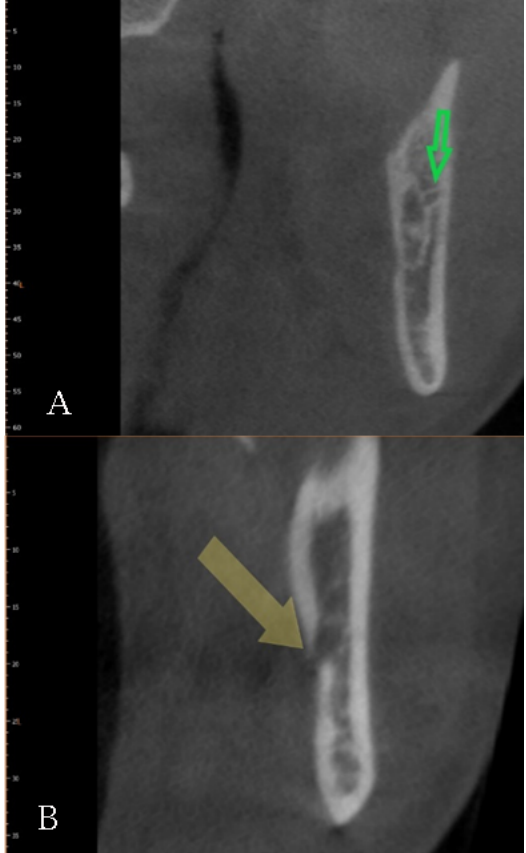
Figure 9. Type 4: ( A ) buccal canal cross-section reconstructions and ( B ) lingual cross-section recon- structions. Arrows indicate the presence of the canal.